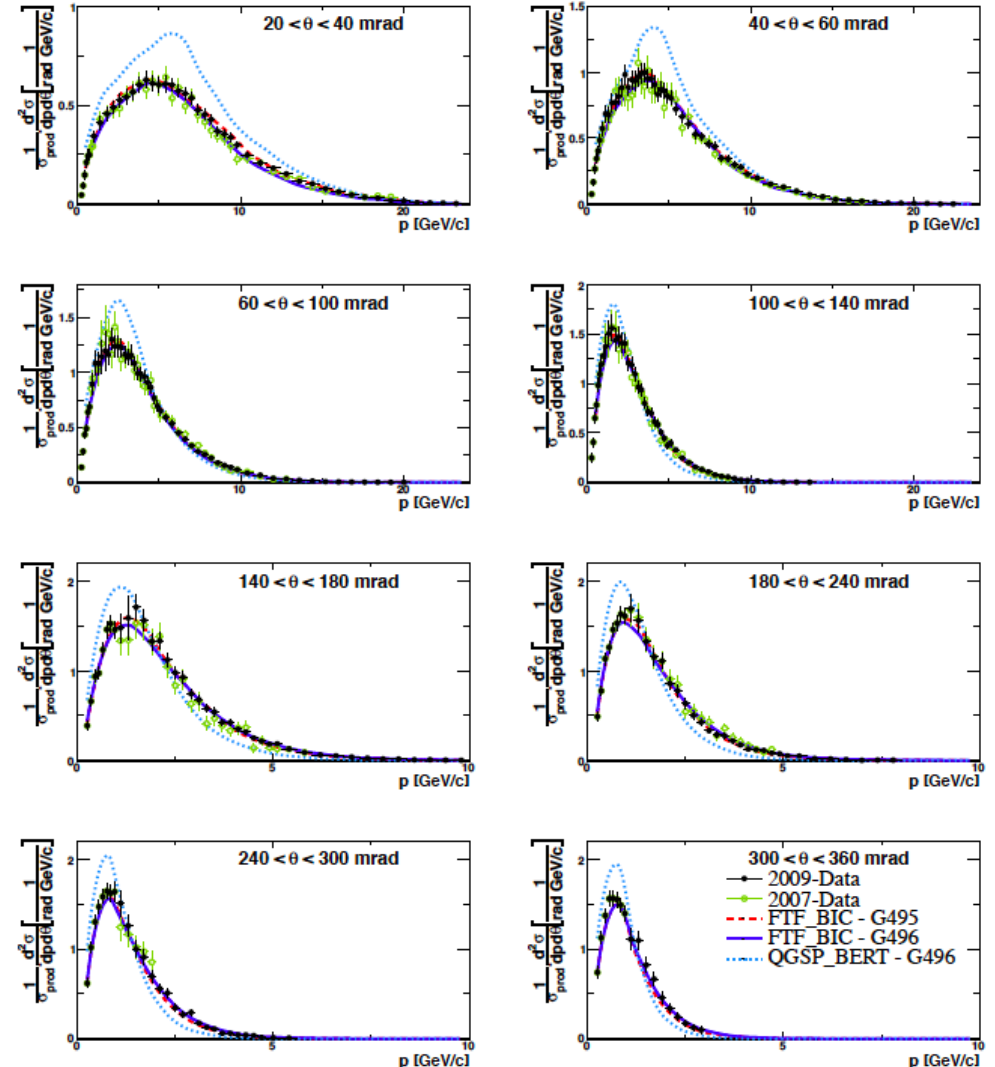
Figure 3. The production cross section of π + in p -C interactions at 31 GeV / c in di ff erent intervals of polar angle θ versus the laboratory momentum p. Error bars indicate statistical uncertainty. Data points are compared to various model predictions [9,